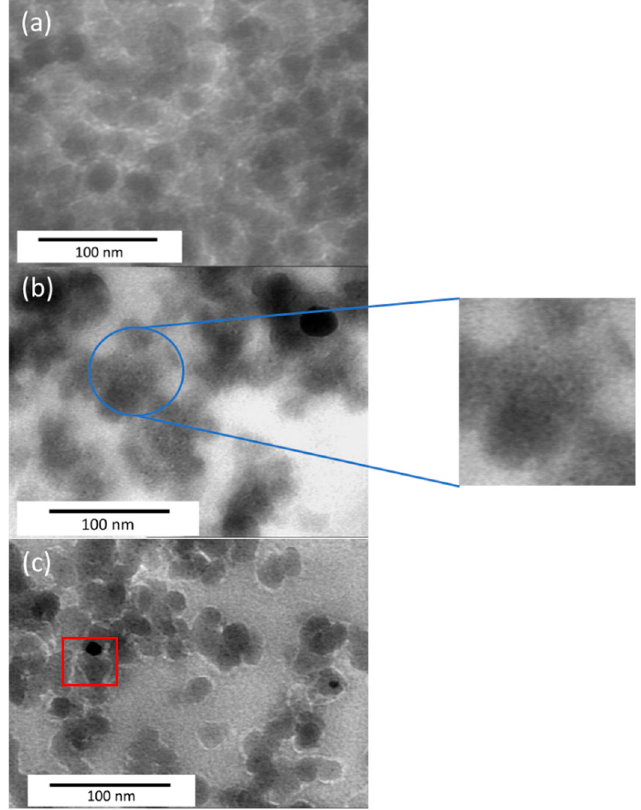
Figure 3. TEM micrographs of ( a ) Ni100, ( b ) Pd33Ni67 and ( c ) Pd50Fe50